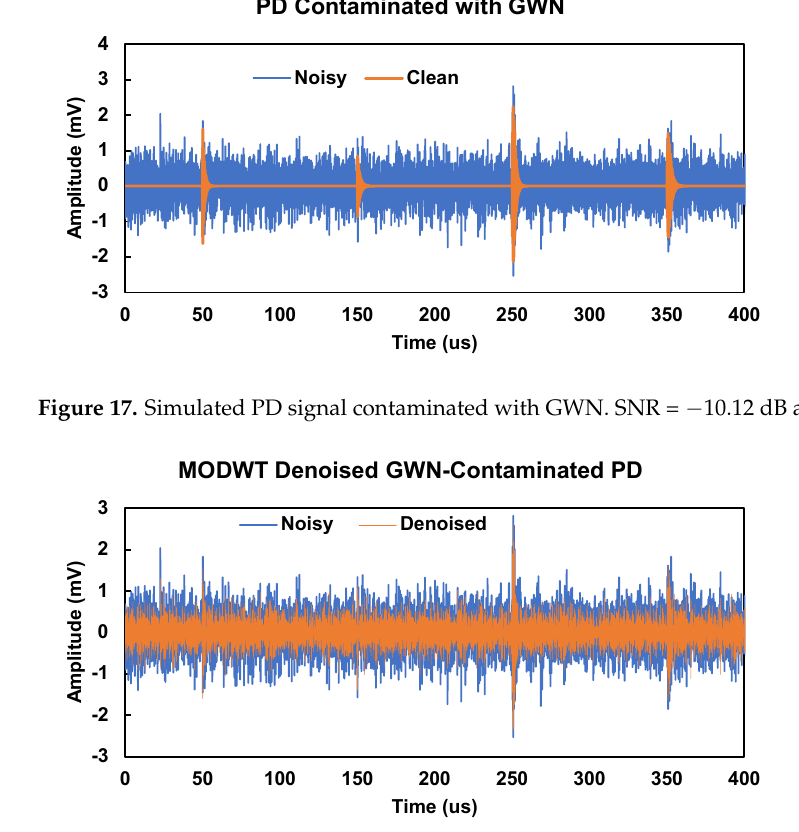
Figure 18. Denoised PD signal contaminated with GWN using MODWT. Input SNR = − 10.12 dB and output SNR = 0.85 dB. Input and output NCC = 0.28 and 0.42,